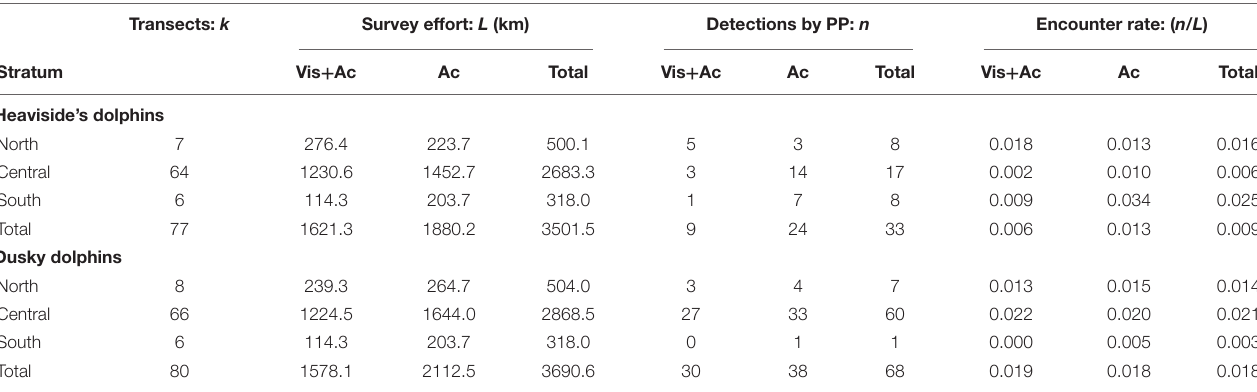
TABLE 4 | Survey effort and detections on systematic transect lines by stratum. Transects: